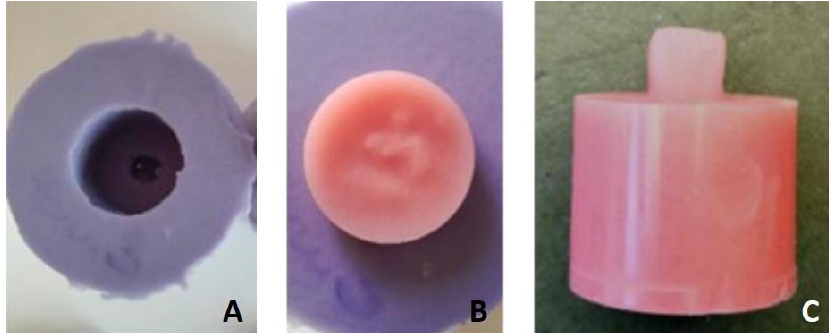
Figure 2. Replication of the tooth shape for Group B (CAD/CAM), as used in Group A: ( A ) silicone mold for duplication of the artificial tooth shape; ( B ) auto-curing PMMA being applied into the silicone mold in liquid state—the milled PMMA block with prepared surface conditioning is put on top of it in order to mate it; ( C ) the finalized shear bond testing specimen of Group B.